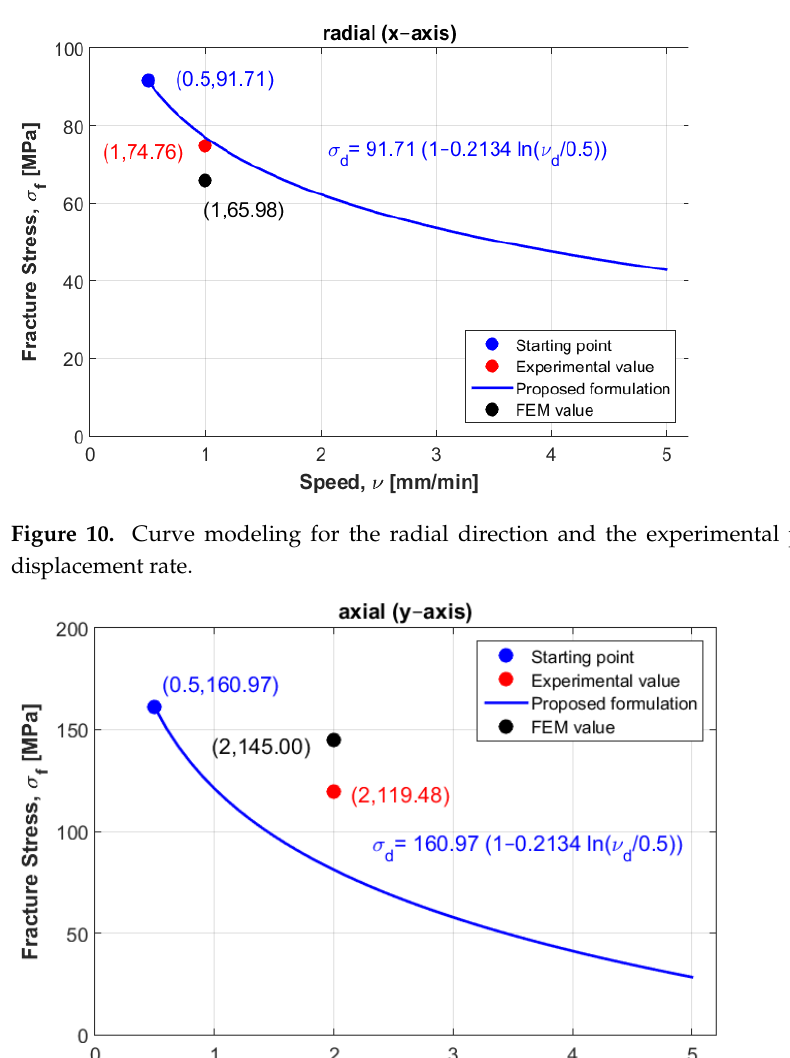
Figure 11. Curve modeling for the axial direction and the experimental point at the third displacement rate.